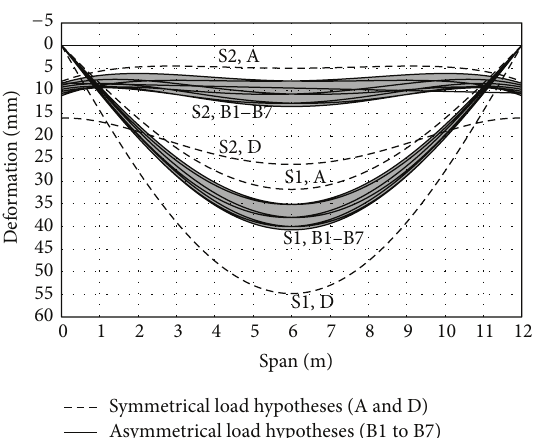
Figure 10: Deformation hypotheses (A), (B1) to (B7), and (D), F1 structural floor type, sections (S1) and